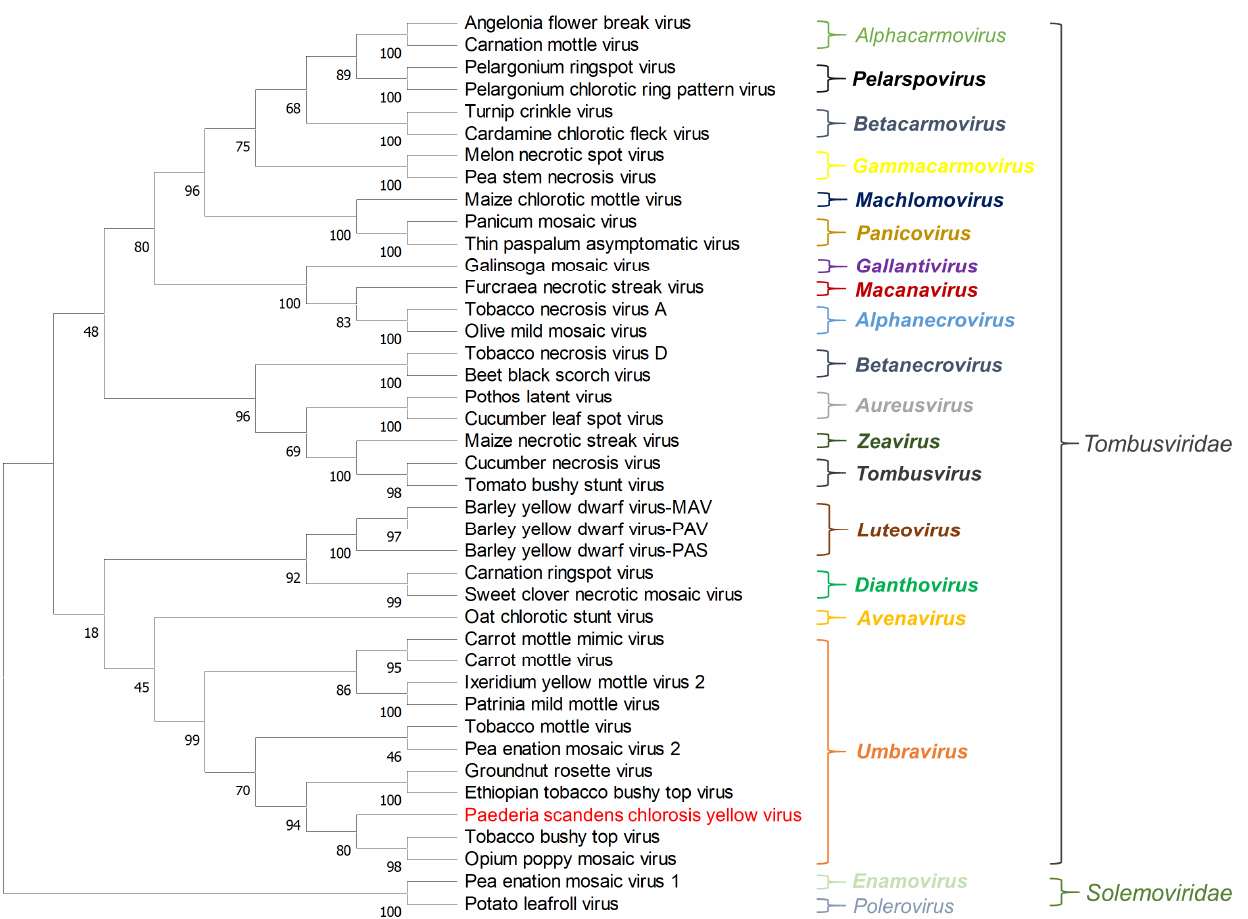
Figure 3. Phylogenetic relationships between PSCYV and other 40 related viruses. The phylogenetic tree was constructed using the aa sequences of RdRps and the maximum likelihood method with 1000 bootstraps. Viruses from the same genus are shown in the same color. PSCYV is shown in red. The bootstrap values are indicated adjacent to the nodes. Accession numbers of these sequences are listed in Table S3.